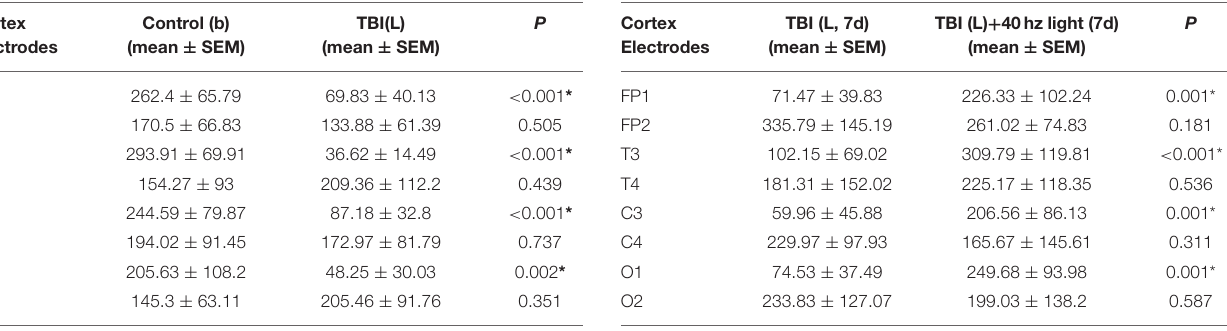
TABLE 3 | Gamma oscillations of control (b) and TBI (L) rats. TABLE 4 | Gamma oscillations of TBI (L, 7d) and TBI (L) + 40hz light (7d)